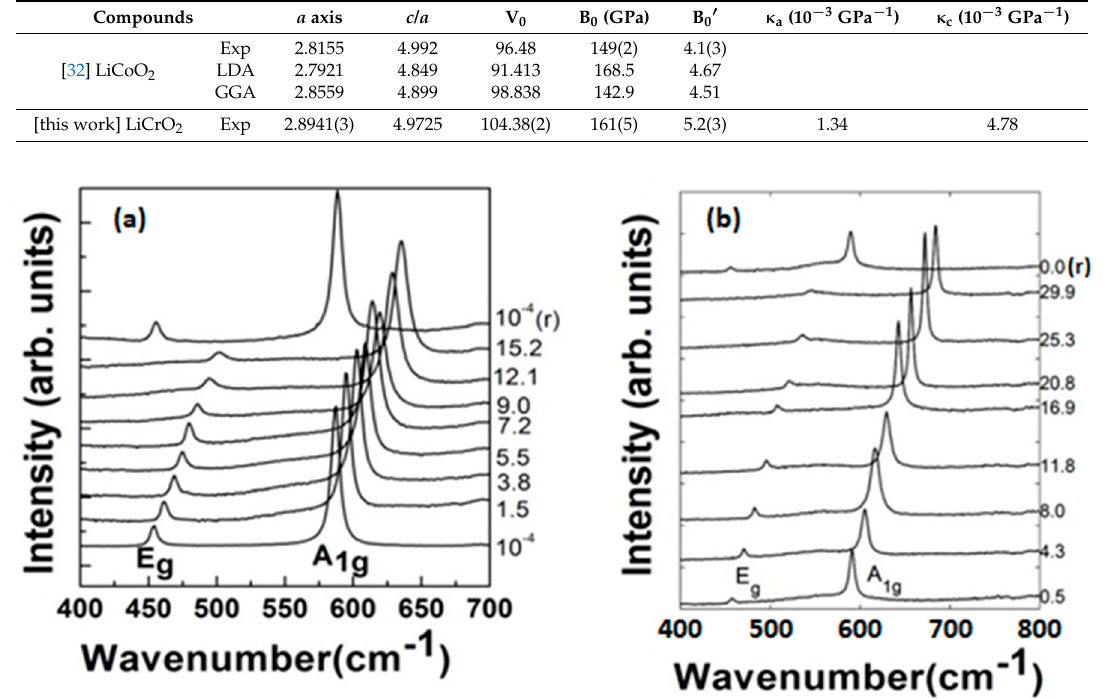
Figure 11. Stacked Raman spectra of LiCrO 2 at a few representative pressures ( a ) with methanol-ethanol-water mixture (MEW), ( b ) with Ne. Numbers at the right hand side y-axis are pressure in GPa. Letter r in figures ( a ) and ( b ) indicates pressure released data.